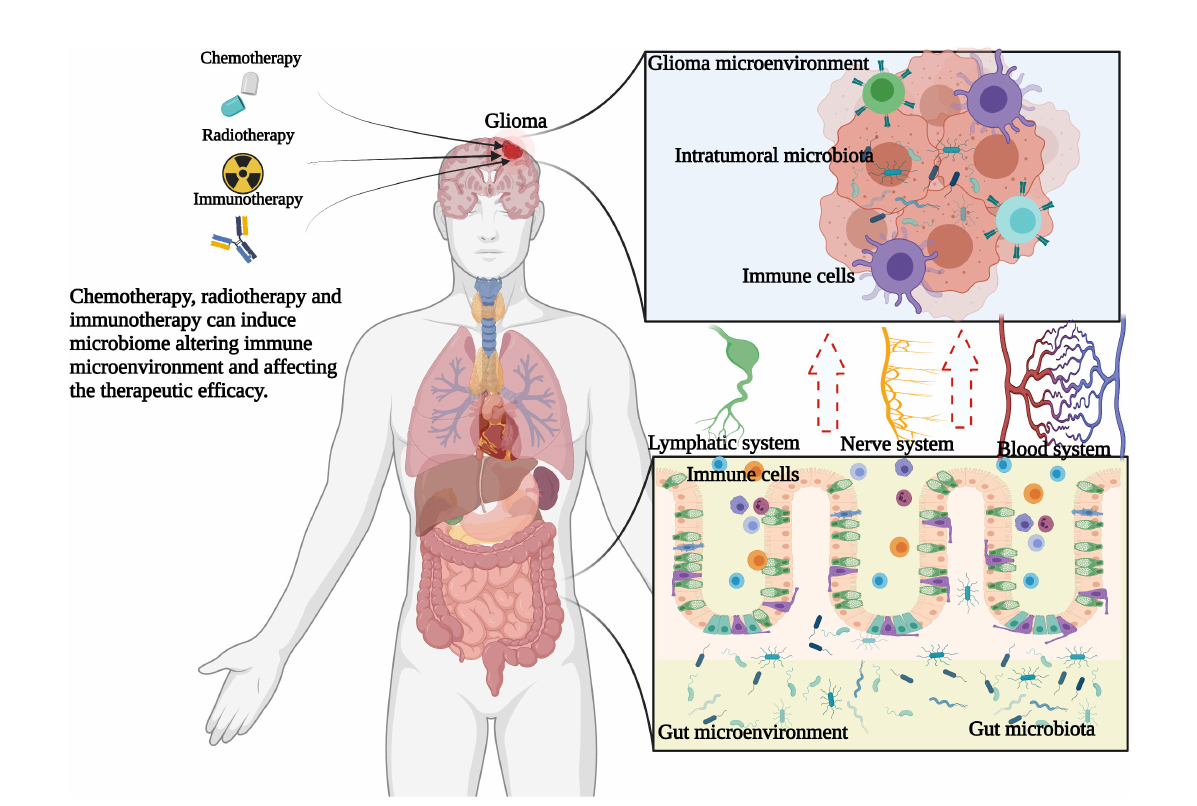
FIGURE 1 Hypothesis of the relationship among gut microbiome, intratumoral microbiome and glioma. Chemotherapy, radiotherapy and immunotherapy can change the glioma microenvironment and gut microenvironment, thus changing the composition of microbiome, thus shaping the immune microenvironment of glioma and further affecting the therapeutic ef fi